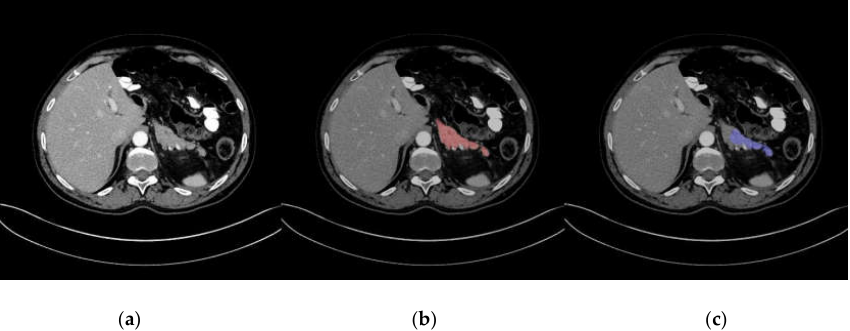
Figure 3. Representative image of a low-quality automatic pancreas segmentation. ( a ) Original computed tomography (CT) image; ( b ) CT image with manually annotated label in red; ( c ) CT image with automatic segmentation in blue, with part of the pancreas excluded from the segmentation.